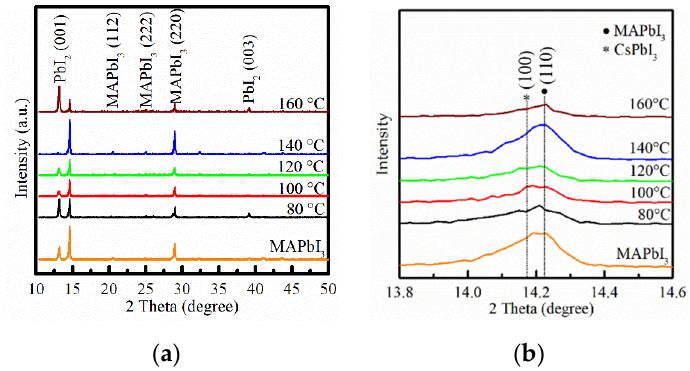
Figure 4. ( a ) XRD patterns of CsPbI 3 -QDs doped perovskite thin films obtained by different annealing